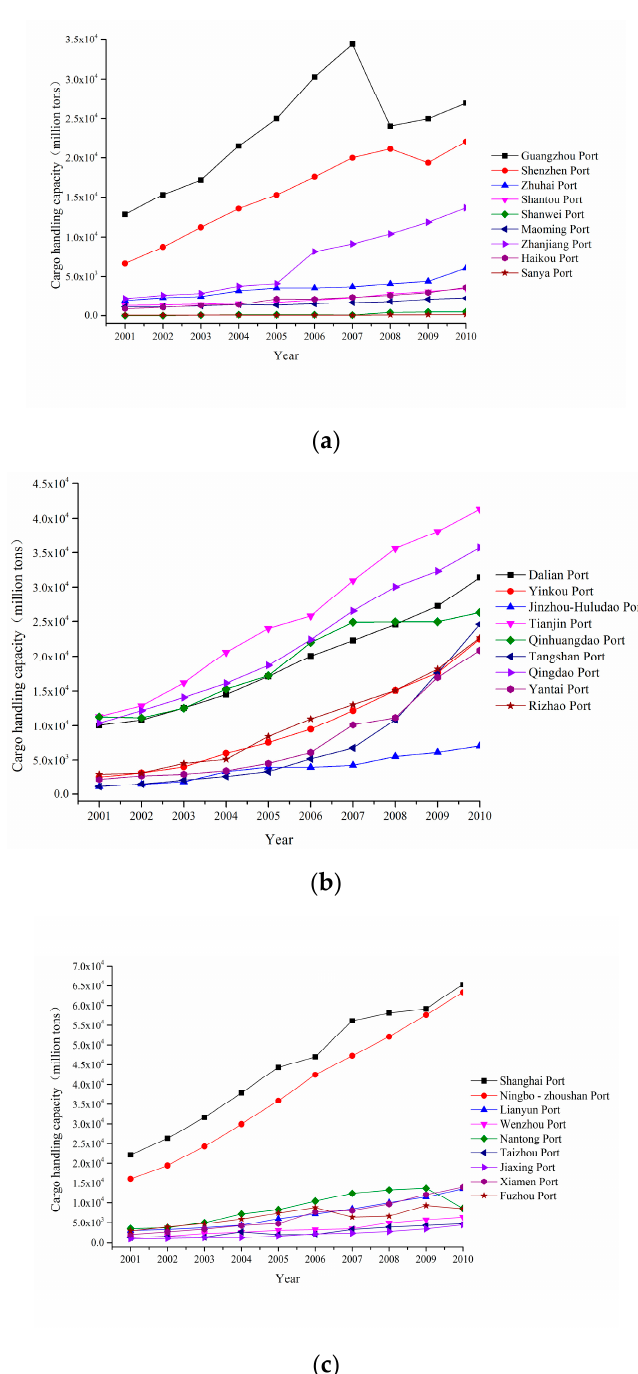
Figure 2. The Cargo handling capacity of coastal ports in each port group from 2001 to 2010: ( a ) cargo handling capacity of coastal ports in the RBAPG from 2001 to 2010; ( b ) cargo handling capacity of coastal ports in the YRDPG & SECPG from 2001 to 2010; ( c ) cargo handling capacity of coastal ports in the PRDPG & SWCPG from 2001 to 2010.